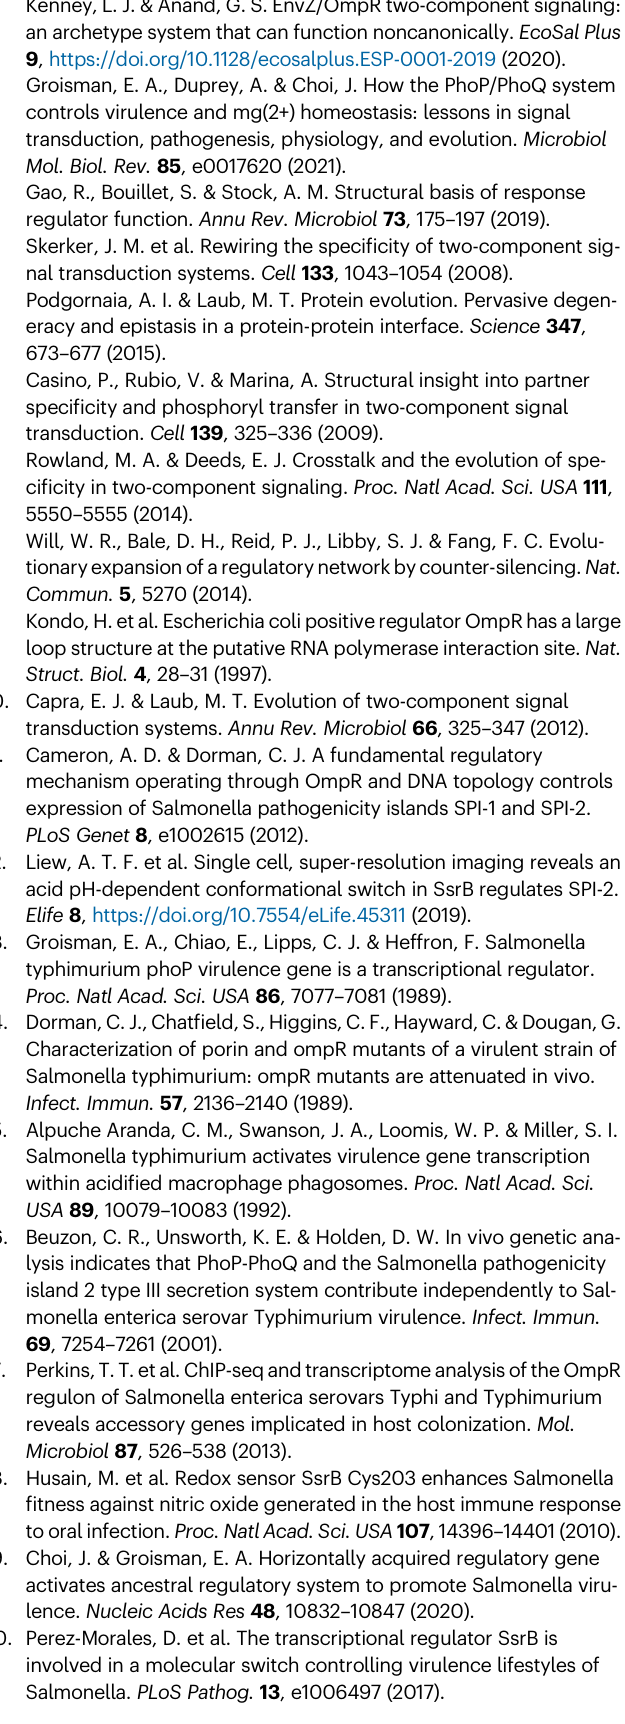
(Table S4) and 20 U RNase inhibitor (cat. # N2611, Promega).